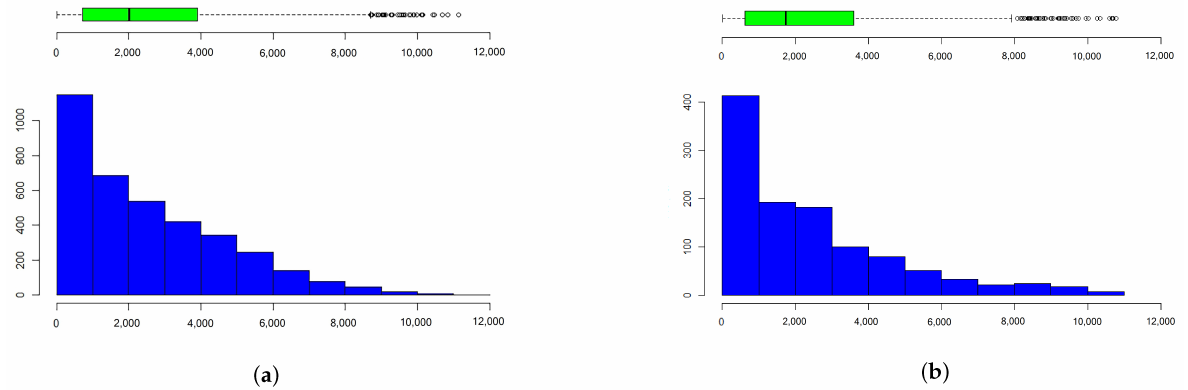
Figure 8. Distribution of the number of communications for a 1-year contract follows a Poisson distribution with λ c = 400 and λ n = 20 according to a node-based model. ( a ) Distribution in the first network. ( b ) Distribution in the second network.